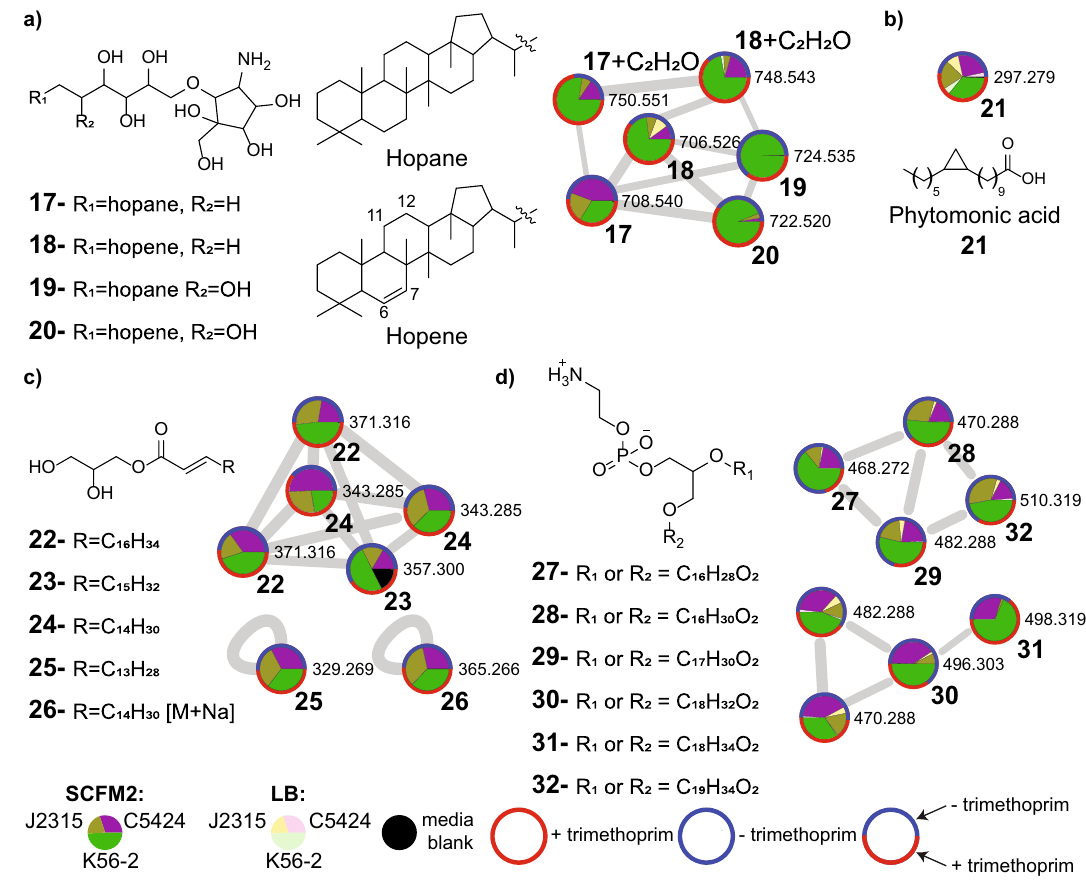
Figure 6. Distribution of various lipids detected across three B. cenocepacia strains in both LB and SCFM2 media. Pie charts within nodes correspond to relative abundance in each strain (green: K56-2, purple: C5424, brown: J2315) and media condition (darker shade for SCFM2 and lighter shade for LB). The coloring of node border represents whether the metabolite was detected only in the presence of trimethoprim (red border), only in the absence of trimethoprim (blue), or both in the presence or absence of trimethoprim (mixed color). A combination of blue and red border color shows total relative abundance of the metabolite in the absence or presence of trimethoprim, respectively across all strains. ( a ) Annotated hopanoid cluster, including bacteriohopanetetrol (BHT) cyclitol ether ( 17 ), bacteriohop-6-enetetrol cyclitol ether ( 18 ), bacteriohopanepentol (BHP) cyclitol ether ( 19 ), and bacteriohop-6-enepentol cyclitol ether ( 20 ). Additionally, an acetylated analog of BHT cyclitol ether ( m/z 750.551) and an acetylated analog of bacteriohop-6-enetetrol cyclitol ether ( m/z 748.543) were detected. ( b ) Node corresponding to phytomonic acid ( 21 ). ( c ) Annotated cluster and nodes representing monoacylglycerols (MGs). Detected MGs vary by number of carbon units on fatty acid chain, and include MG(19:1) ( 22 ), MG(18:1) ( 23 ), MG(17:1) ( 24 ), MG(16:1) ( 25 ), and the [M + Na] adduct of MG(17:1) ( 26 ). ( d ) Clusters corresponding to phosphatidylethanolamines (PEs). The PEs varied by acyl chain length, and were annotated as 2-OH-PE(16:1) ( 27 ), 2-OH-PE(16:0) ( 28 ), 2-OH-PE(17:1) ( 29 ), 2-OH- PE(18:1) ( 30 ), 2-OH-PE(18:0) ( 31 ) and 2-OH-PE(19:1) ( 32